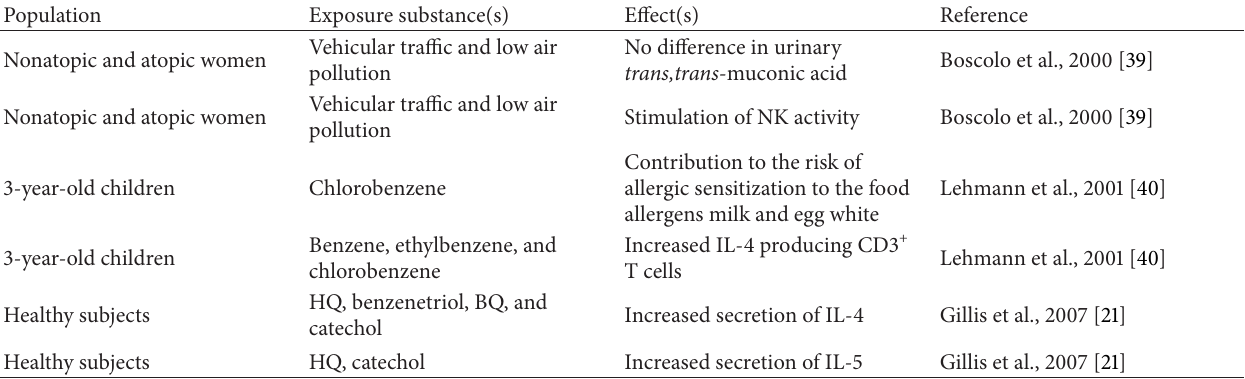
Table 2: Summary of considered studies on atopy induced by benzene and/or its